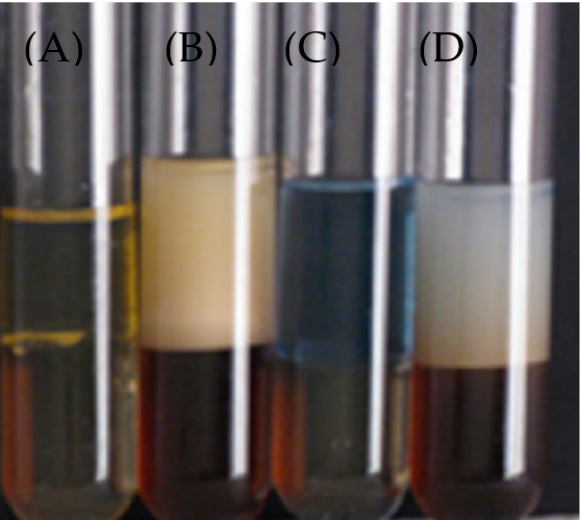
Figure 11. Emulsification index. ( A ) Kerosene—negative control; ( B ) emulsification of kerosene by culture supernatant; ( C ) diesel oil—negative control; and ( D ) emulsification of diesel oil by culture supernatant. Source: [95].